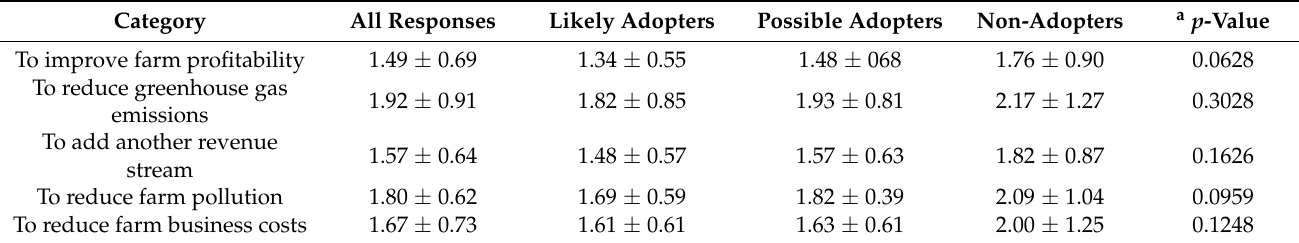
Table 2. Summary of survey responses to Likert-scale questions on the importance of various AD benefits.